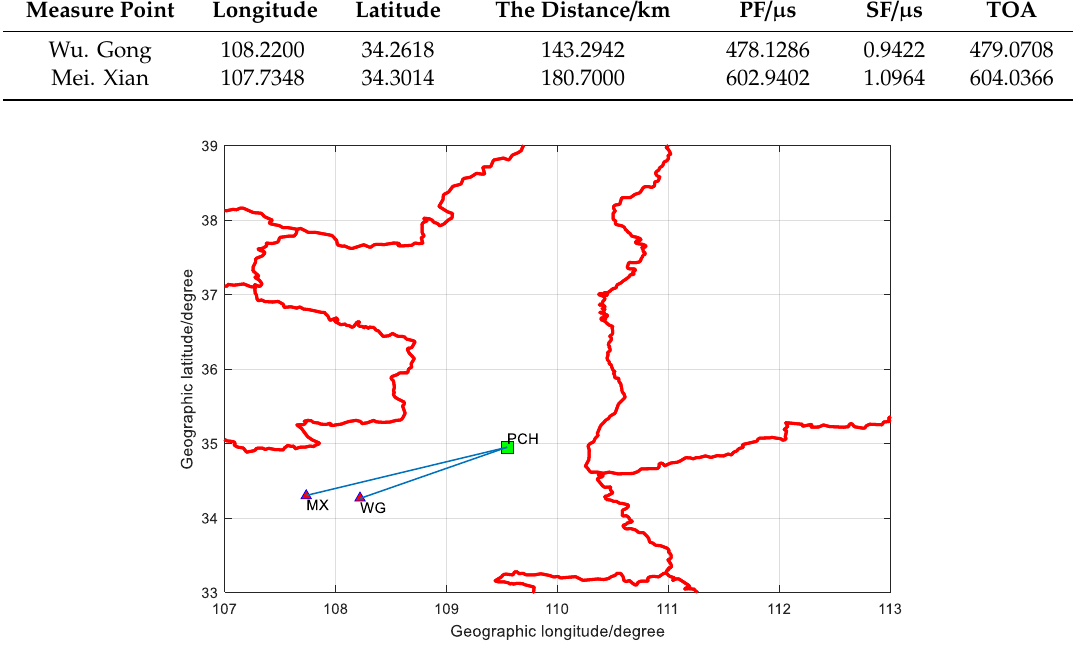
Figure 8. Distribution of test point.